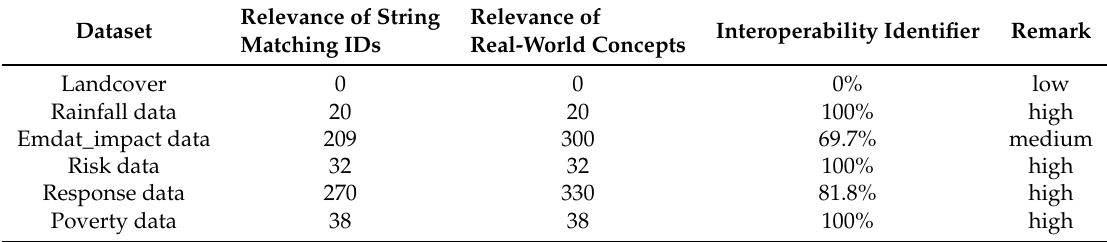
Table 3. Interoperability identifier ratio with the DesInventar dataset as